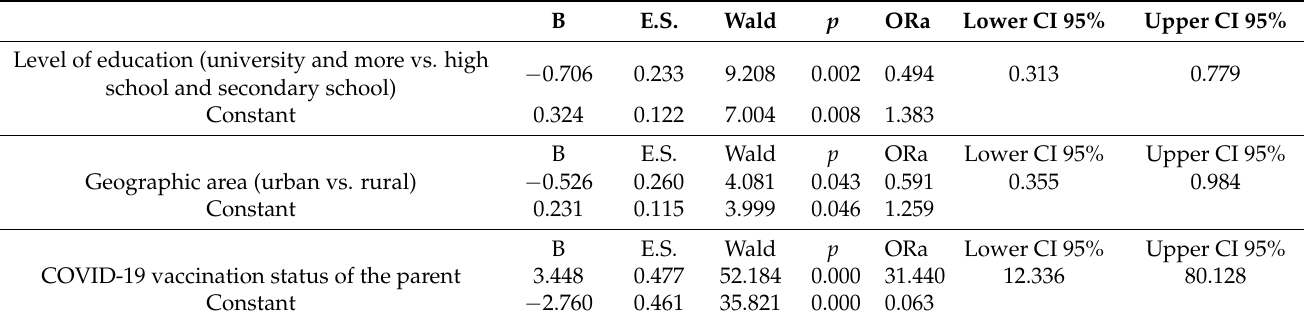
Table 5. Logistic regression model for COVID-19 vaccination of children aged between 5 and 11 years.